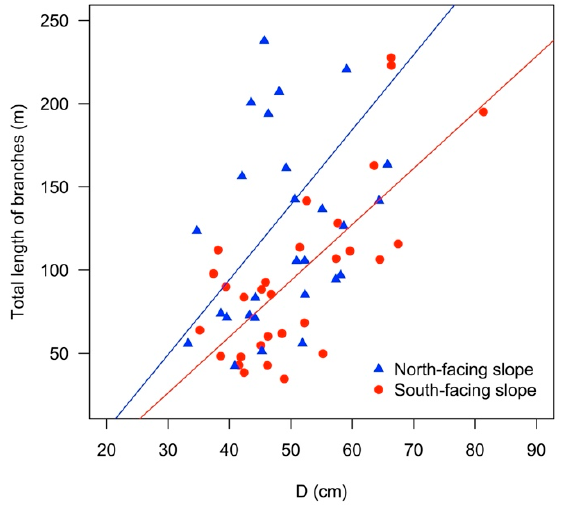
Figure 2. The relationship between total length of branches and D for trees growing on the north- facing slope (blue triangles) and on the south-facing slope (red dots). The regression lines for the two groups follow the same color differentiation.